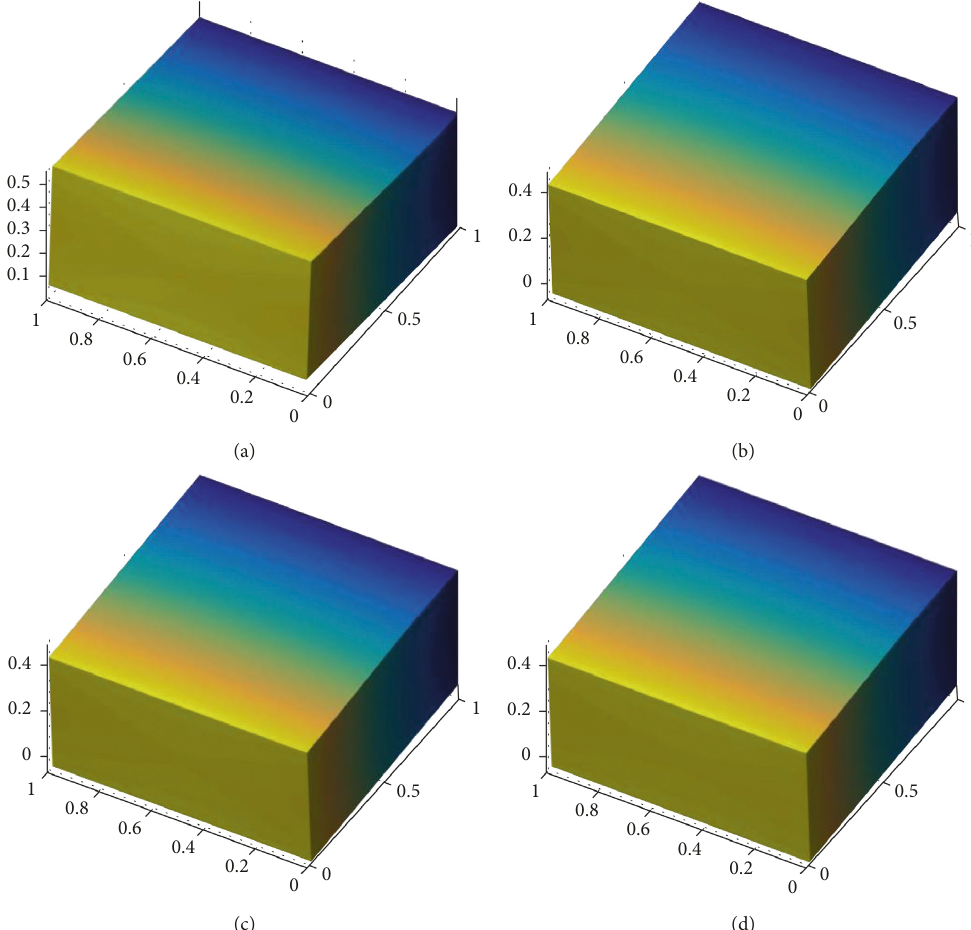
� 10 2 ; (b) k � 10 6 ; (c) k � 10 10 ; v v v